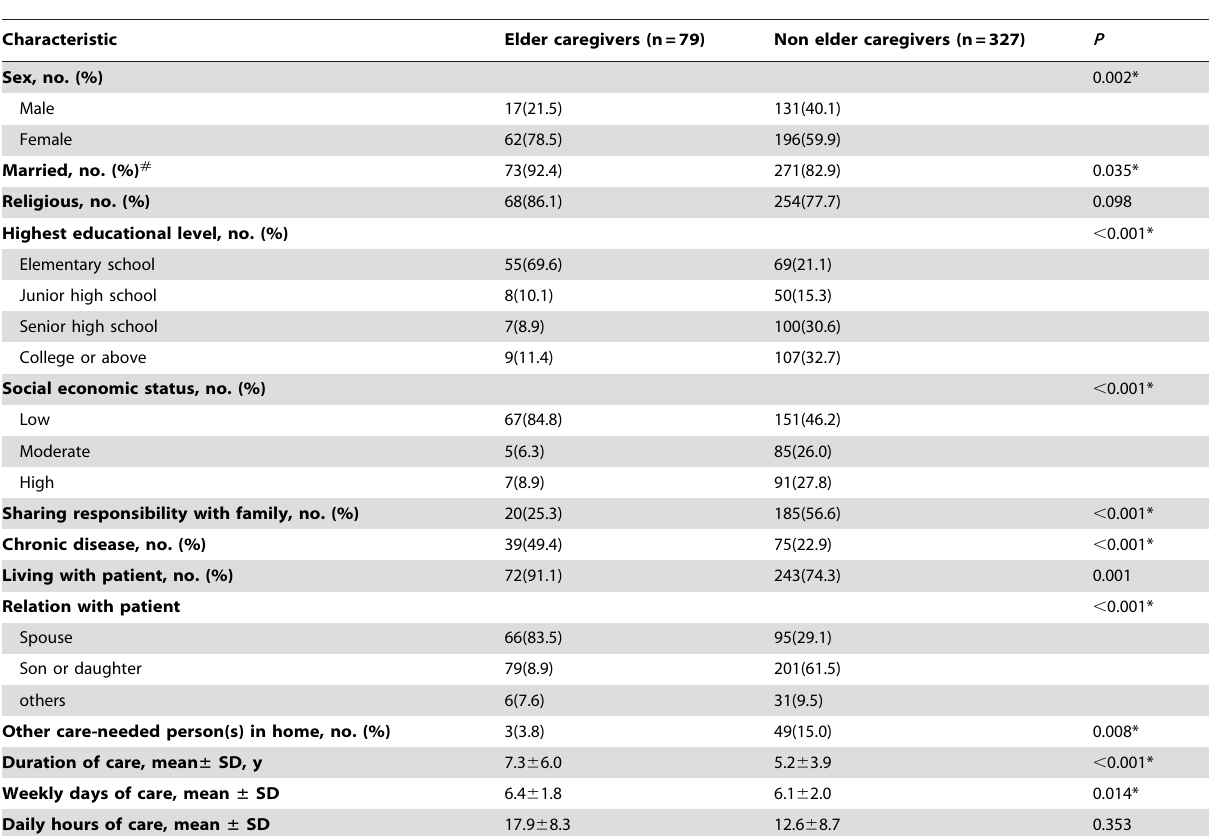
Table 1. Characteristics of study participants.